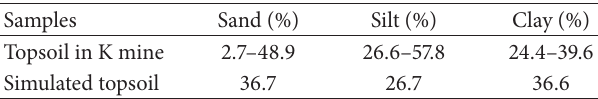
Table 2: Soil texture classes of topsoil in the K mine and the simulated